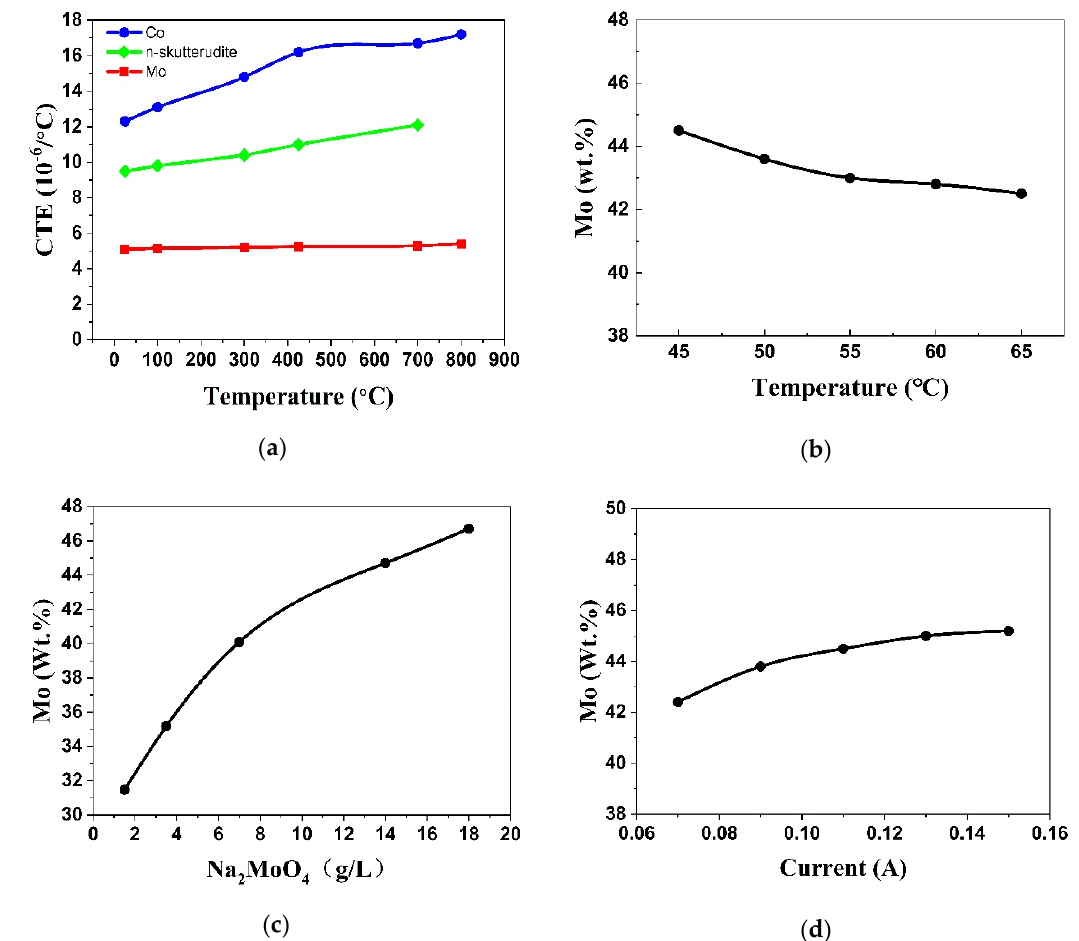
Figure 2. ( a ) The temperature-dependent coefficient of thermal expansion (CTE) of Co, skutterudite compound and Mo. ( b ) The effects of temperature on the Mo content of the electroplated layer. ( c ) The effects of the Na 2 MoO 4 concentration on the Mo content of the electroplated layer. ( d ) The effects of the current on the Mo content of the electroplated layer.